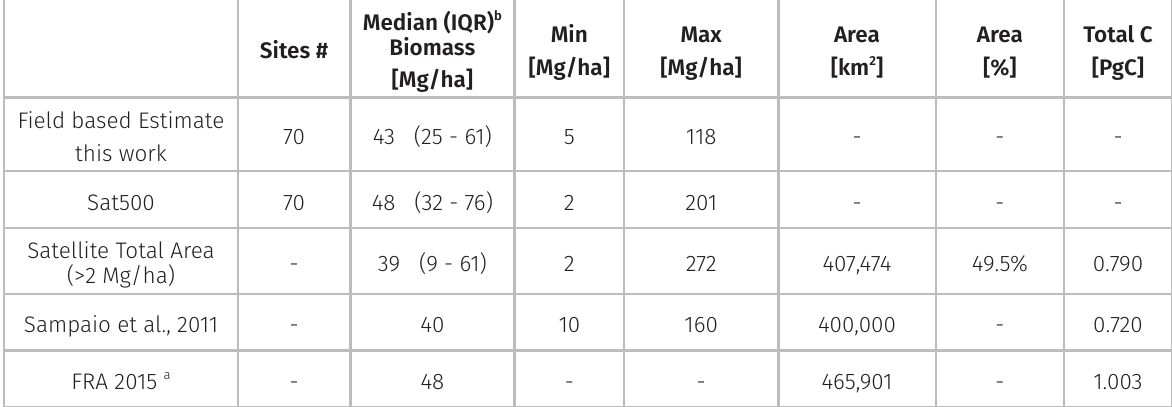
Table I. Descriptive statistics of field and satellite data across the Caatinga, and literature references. Total carbon estimates were computed considering a ratio of C to biomass of 0.45 for Caatinga vegetation (Souza et al. 2013, Pereira Jr et al. 2016). The median and the inter quartile range (IQR, with the lower and the upper quartile) are shown.